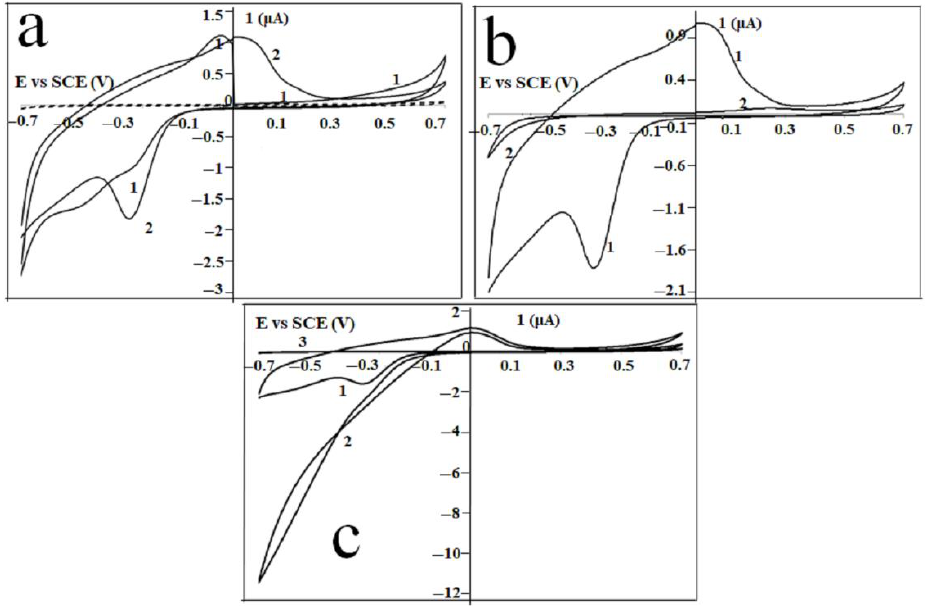
Figure 8. Current-potential behavior of ( a ) Au|Gel (dotted) and Au|Gel/CdS electrode (solid) in HEPES buffer solution: first (1) and fifth (2) scan, and ( b ) Au|Gel/CdS (1) and a Au|MOH|Gel/CdS (2) electrode in a HEPES buffer solution. Scan 5 of each experiment is shown, ( c ) current-potential behavior of Au|Gel/CdS electrode in the absence (1) and presence (2) of mM H 2 O 2 . Curve 3 is the current-potential behavior of Au|Gel electrode in presence of mM H 2 O 2 .